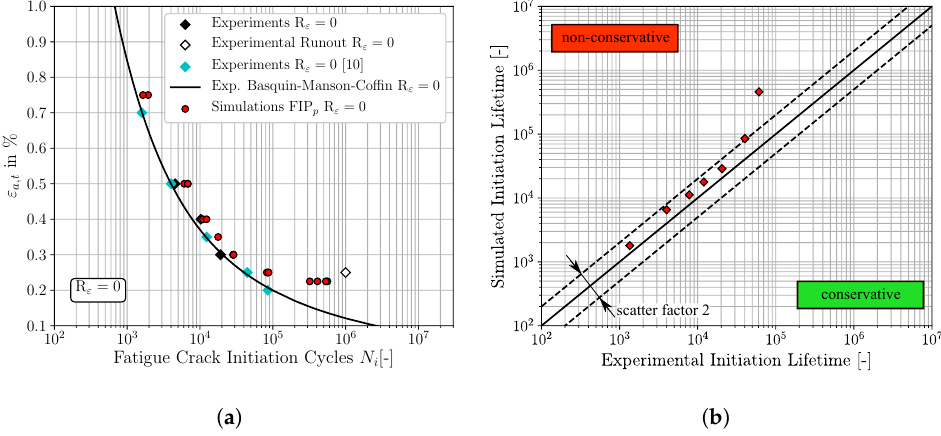
Figure 11. Comparisons of the fatigue crack initiation predictions based on the non-local accumulated plastic slip and the experimental fatigue crack initiation lifetime, for R ε = 0: ( a ) ε -N-curve ( b ) lifetime correlation plot.